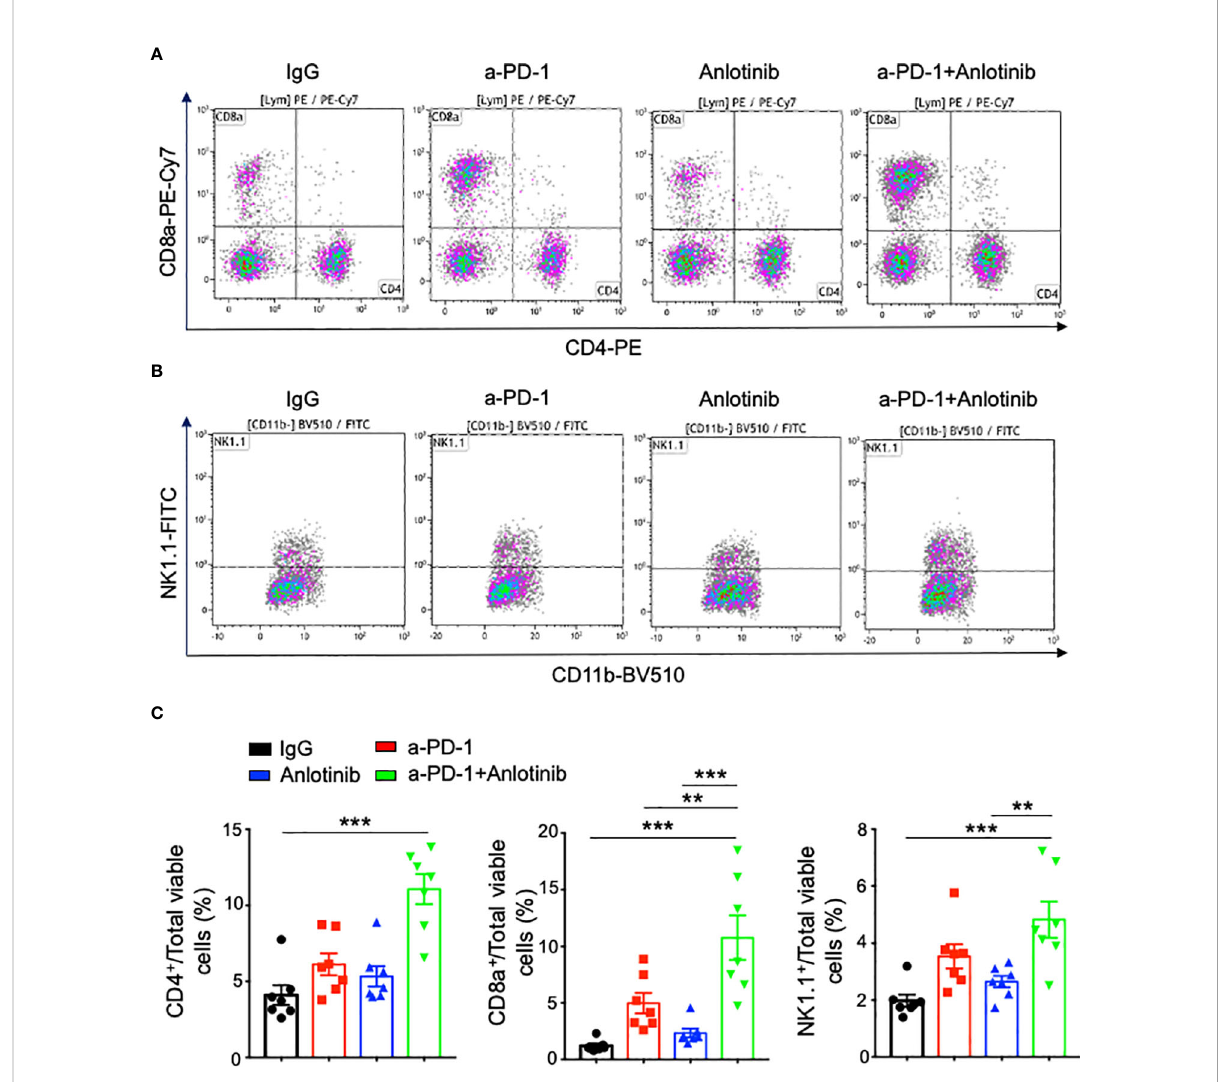
FIGURE 6 The combination of effective low-dose Anlotinib and anti-PD-1 therapy increased the percentages of intratumoral T and NK cells. EO771 breast tumor- bearing mice and the combination of Anlotinib and anti-PD-1 therapy were conducted as described in Figure 4. Tumor tissues were collected and analyzed by fl ow cytometric analysis. (A, B) Representative fl ow cytometric plots of intratumoral CD4 + , CD8 + T, and NK cells. (C) The percentages of intratumoral CD4 + , CD8 + T, and NK cells. The signi fi cance was determined by one-way ANOVA ( n = 7 mice per group). The data are presented as means±SEM. ** p < 0.01; *** p <